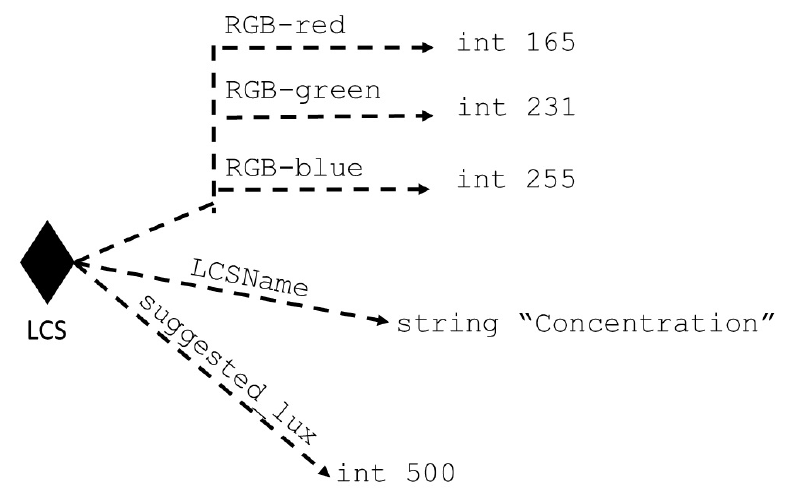
Figure 7. An example of the modelling of Luminous Comfort Setting (LCS); individuals are represented with diamonds, concepts are represented with circles, and roles are represented with arrows (dashed arrows indicate datatype properties). Please note that this specific LCS here represented is one of the results coming from the evaluation of visual comfort in a hotel room (described in Section